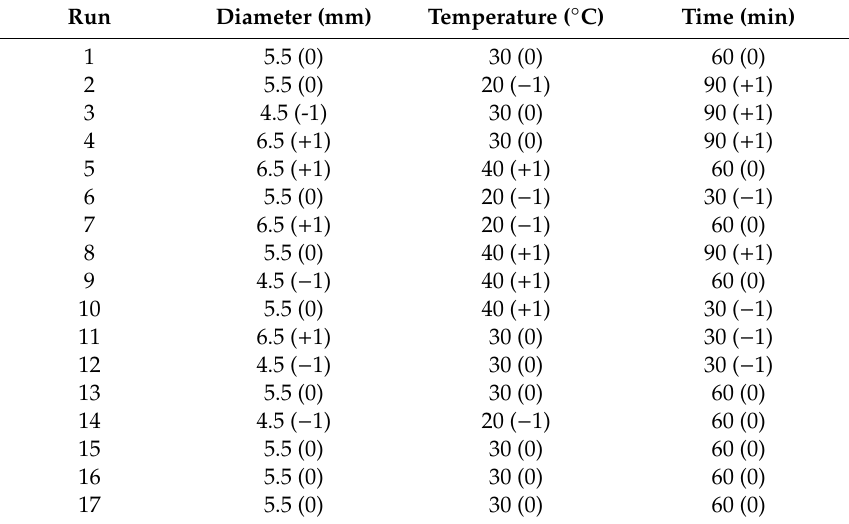
Table 6. Actual factors of the experimental design (coded